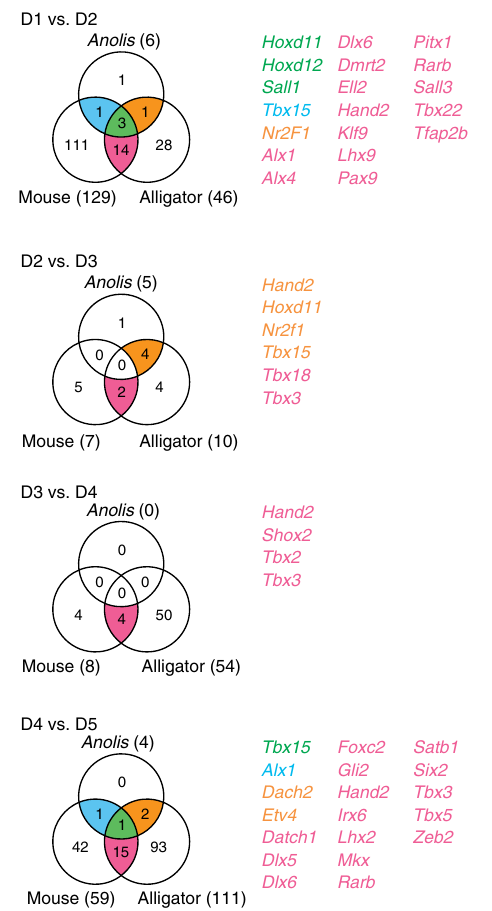
Fig. 3 Few genes are differentially expressed at the same position between pentadactyl limbs. Venn diagrams of one-to-one orthologous transcription factors genes for mouse, alligator, and Anolis that were identi fi ed as differentially expressed between adjacent digits with an FDR threshold of